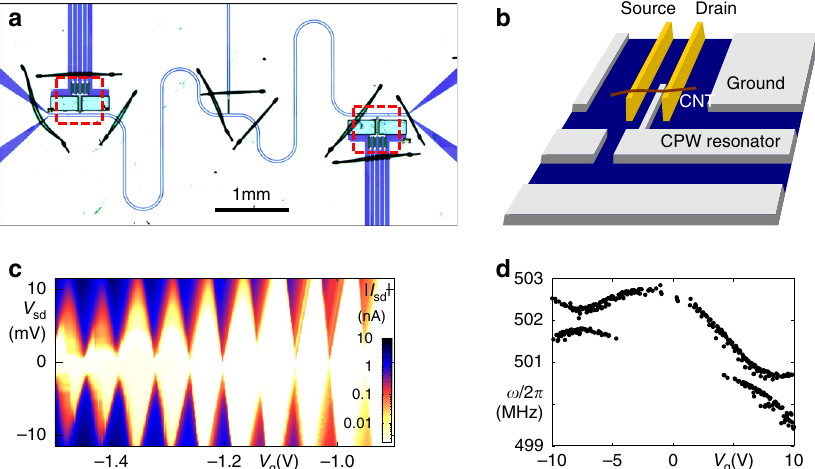
Fig. 1 Integrating a suspended carbon nanotube into a microwave cavity. a Optical micrograph showing a niobium-based λ /2 coplanar waveguide